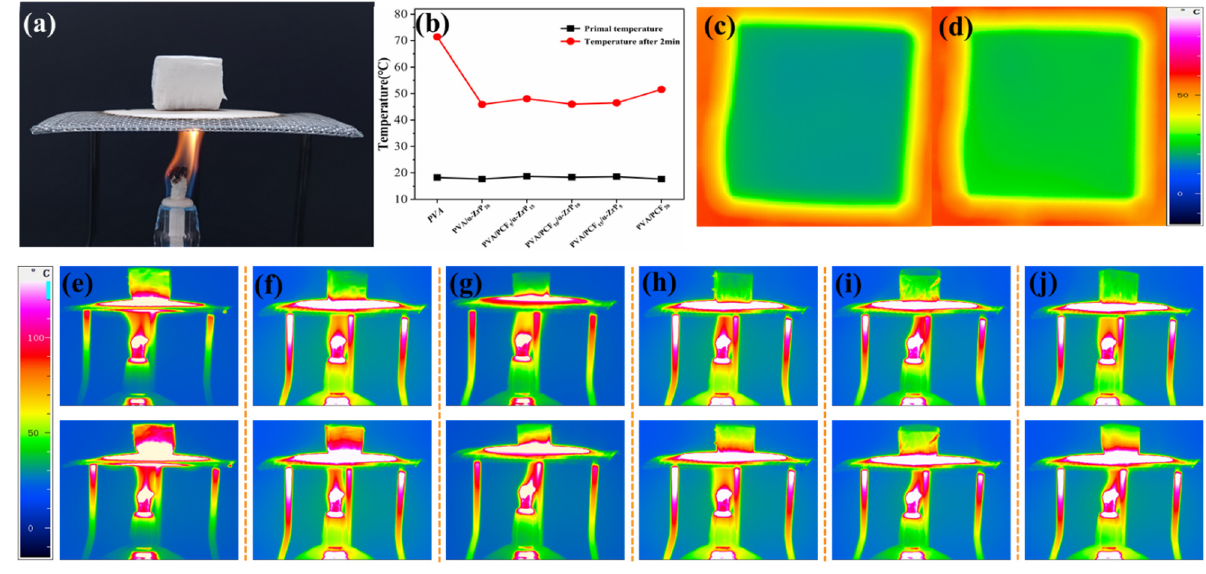
Figure 7. Application of thermal management of PVA/PCF x / α -ZrP y . ( a ) Photograph of the heating process; ( b ) Comparison of the original temperature of aerogel and the temperature after heating for 2 min; ( c , d ) Infrared thermal imaging of PVA/PCF 10 / α -Zr 10 in 60 °C after 5 min. Thermographic images of PVA ( e ), PVA/ α -Zr 20 ( f ), PVA/PCF 5 / α -ZrP 15 ( g ), PVA/PCF 10 / α -ZrP 10 ( h ), PVA/PCF 15 / α -ZrP 5 ( i ), and PVA/PCF 20 ( j ) aerogels on a stage heated by alcohol lamp fire.